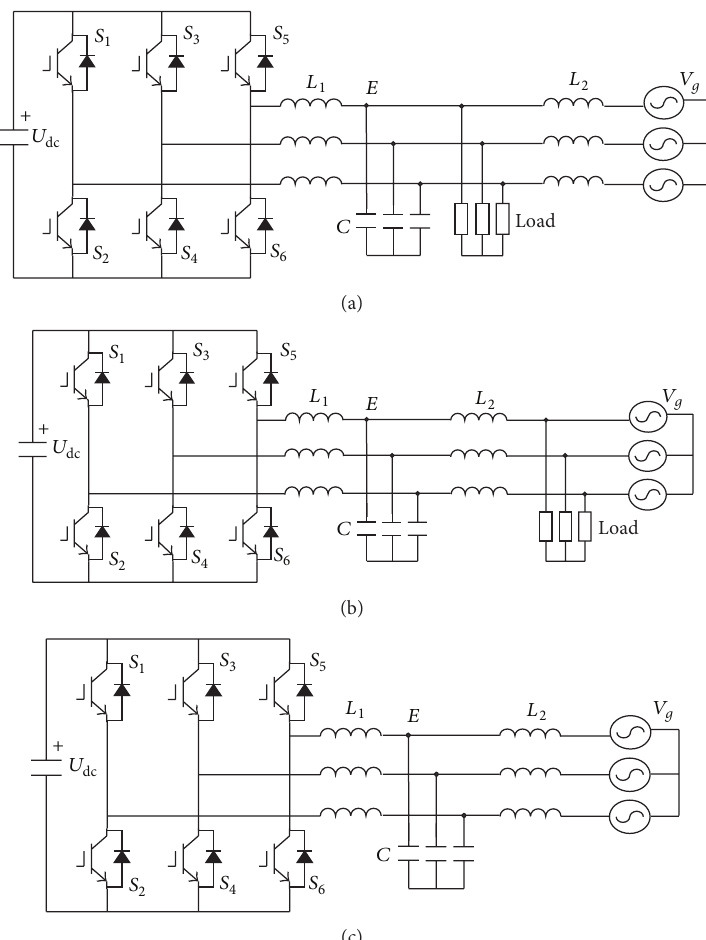
Figure 2: Grid-connected inverter with LCL filter configuration: (a) case I; (b) case II; (c) case III.